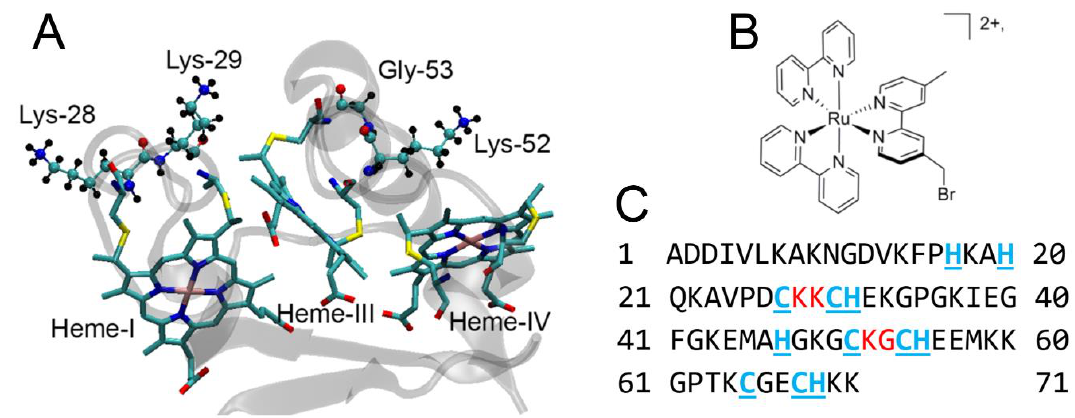
Figure 1. ( A ): Structure of PpcA, a 3 heme c-type cytochrome from Geobacter sulfureducens showing orientations of Lys-28, Lys-29, Lys-52, and Gly-53 residues with respect to the heme groups. ( B ): structure of Ru(II)(bpy) 2 (4-bromomethyl-4′-methyl-2,2′-bipyridine, the photosensitizer used in this work. ( C ): sequence of PpcA showing in underlined blue positions of heme ligands and in red locations of cysteine mutations.